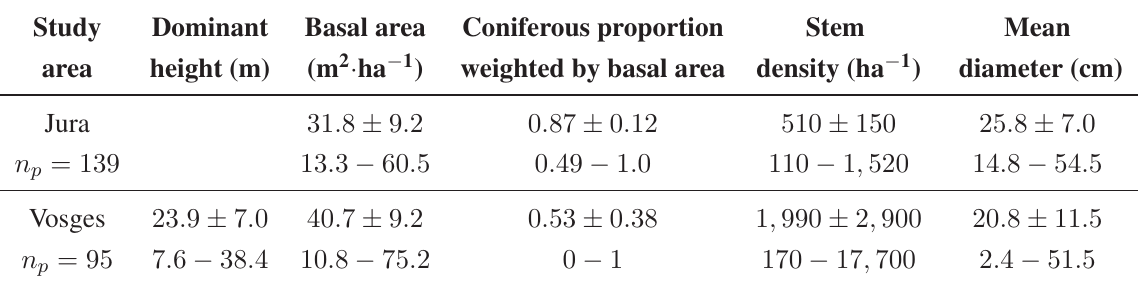
Table 1. Forest statistics for the two study areas. The means ± standard deviations are on the first line, minimum–maximum values are on the second